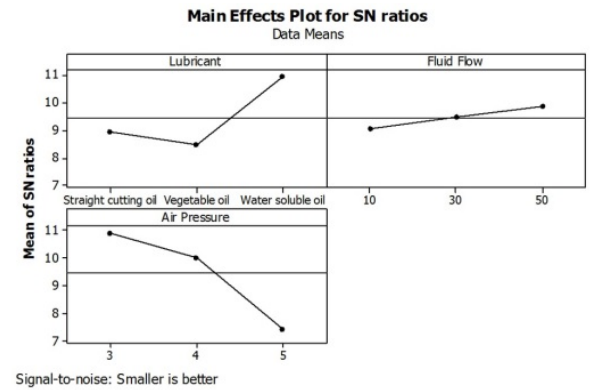
1 Figure 2 indicated the S / N response graph. From the S / N response analysis, in order to get the best R a, the optimum MQL parameters were water soluble oil used for the lubricant, 50 mL/h for the flow rate, and 3 kg/cm 2 for the pressure. This result in the study is reasonably close to those in the related researches about optimization of MQL conditions to reduce tool wear such as the study of Thakur et al. [13] and the study of Gandhe et al. [14]. Water soluble oil is considered to be the best lubricant available due to the inclusion of its non ‐ flammable, good cooling, low viscosity and